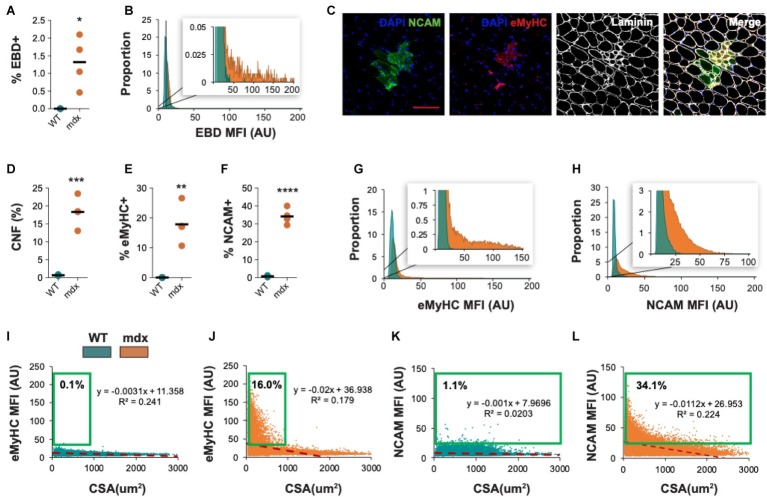
Morphometric analysis of dystrophic pathology in mdx mice. (A) Frequency of injured fibers (% EBD+) in entire quadriceps cross-sections of WT and mdx mice. (B) Histogram of muscle EBD expression showing individual myofiber EBD expression displayed as mean fluorescence intensity (MFI). n = 4 for each group. (C) Representative images of mdx mouse quadriceps cross-sections stained with DAPI (blue), NCAM (green), eMyHC (red), and laminin (white). The percentage of centrally-nucleated [CNF, (D)], eMyHC+
(E), and NCAM+
(F) fibers (of all fibers) in entire WT and mdx quadriceps cross-sections. (G,H) Histogram of eMyHC and NCAM expression showing individual myofiber expression displayed as MFI. Teal = WT, orange = mdx. (I–L) Linear regression analysis comparing eMyHC or NCAM MFI and myofiber CSA (μm2) in WT and mdx mice. Each dot represents a single myofiber. Red-dashed line corresponds to the equation generated by the linear regression analysis. n = 4 for each group. The boxed regions reflect data points that were above the background signal. Scale bar = 100 μm. AU = arbitrary units. Four-week-old mice were used. *p < 0.05, **p < 0.01, ***p < 0.001, and ****p < 0.0001 using an unpaired two-tailed t-test with Welch’s correction.